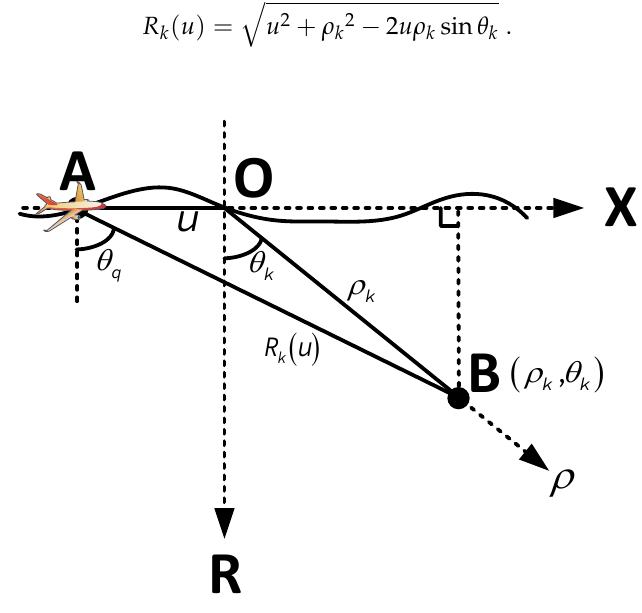
Figure 1. Squint SAR geometry in the slant-range